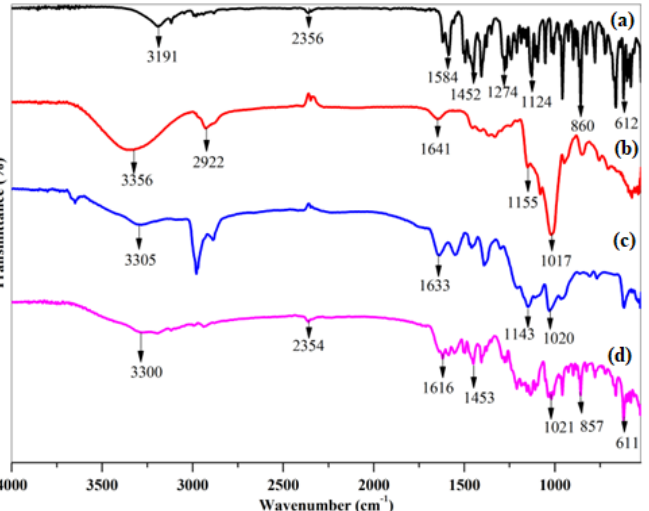
Figure 3. FTIR Spectra of pure VRC ( a ), HP β CD ( b ) and Blank ( c ) and loaded polymeric nanobeads ( d ).